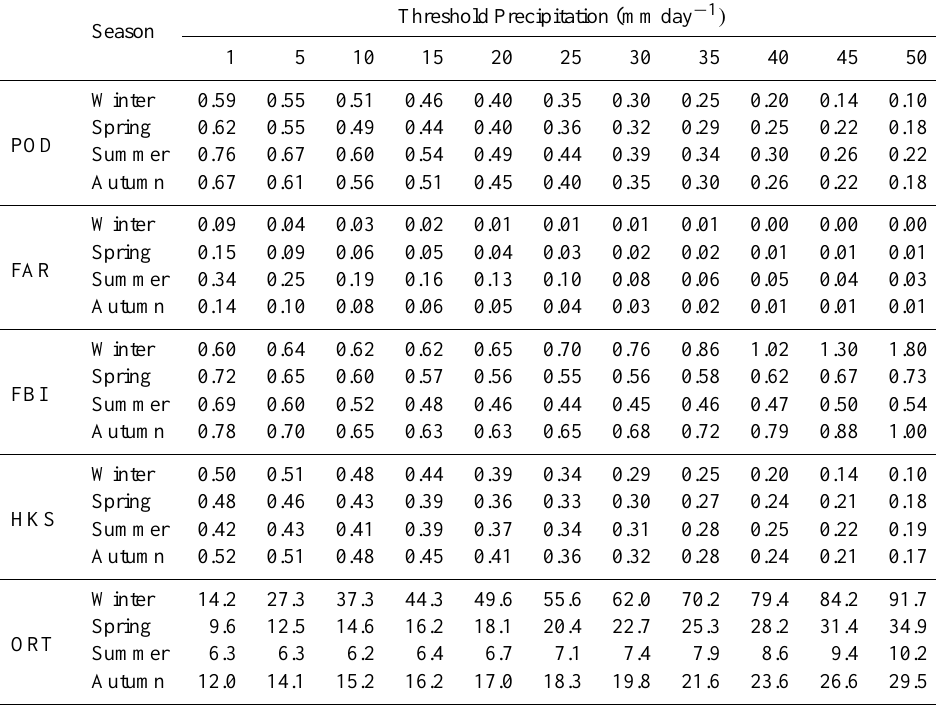
Table 7. Hit rate statistics (probability of detection (POD), false alarm rate (FAR), frequency bias (FBI), Hansen-Kuipers Score (HKS) and odd ratio (ORT)) for WRF-Chem and TRMM daily precipitation data during winter, spring, summer and autumn at different threshold